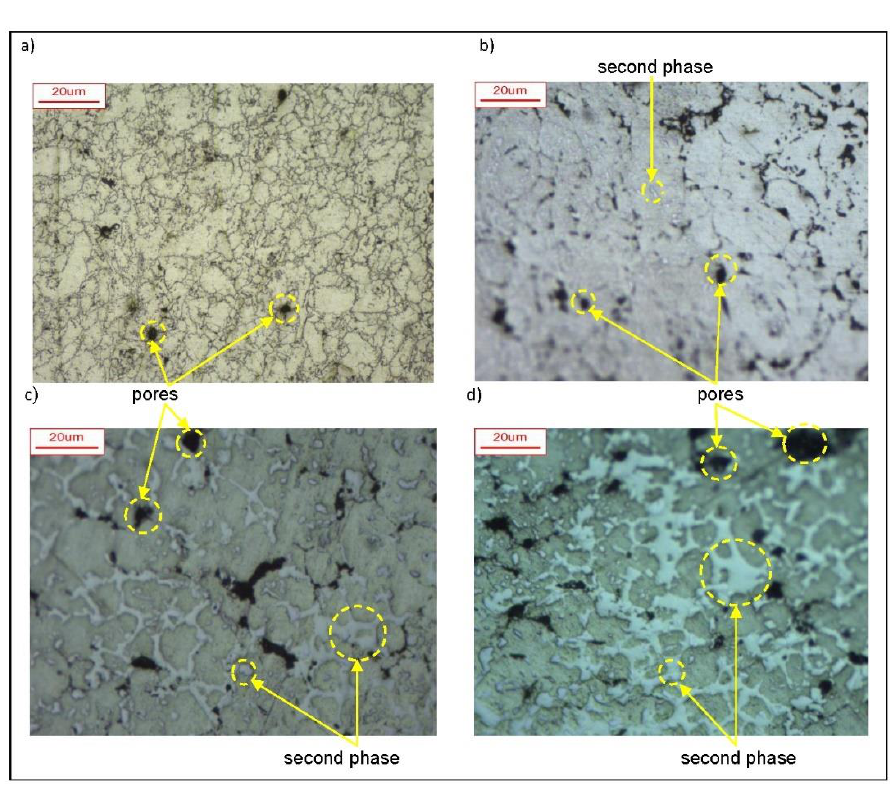
Fig. 7. OM images of the samples a) A 1100/15, b) B 1100/15, c) C 1100/15 e d) D